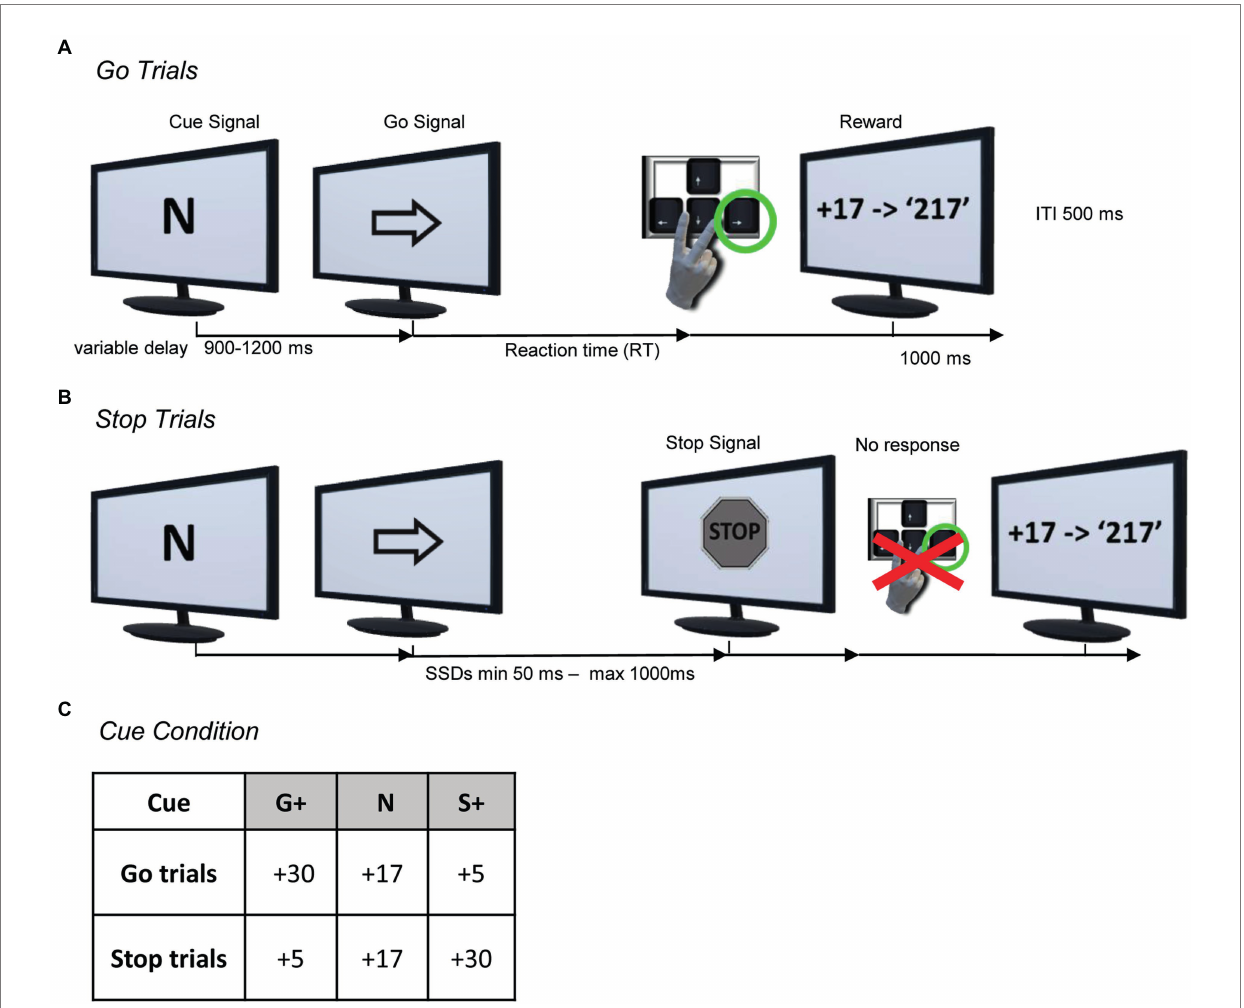
FIGURE 1 Behavioral paradigm. (A,B) Modified version of the Stop-Signal Task (sequence of events for the Neutral Condition; i.e. Cue: N). Each trial started with the Cue Signal, which indicated the type of reward condition to the subject; i.e., the amount of the reward they should expect if they correctly performed the Go Trial (see A ) or a Stop trial (see B ). After a variable delay, a Go Signal (right or left arrow) appeared and the subject had to press the arrow key on the keyboard according to the Go Signal to receive the reward as points (see A ) . Occasionally, at a variable delay (SSD) from the Go Signal, a Stop Signal appeared and the subject had to inhibit the action to receive the reward (see B ). (C) Overview of the Cue Signals associated with the respective rewards for each Cue Condition. The amount of reward for every Cue Condition was differently associated with Go and Stop Trials as follows: Go+ Condition (G+, as Cue Signal) was associated with higher reward for successful Go Trials compared to successful Stop Trials; Stop+ Condition (S+, as Cue Signal) was associated with reversed reward amount; Neutral Condition (N, as Cue Signal) was associated with equal amounts of reward for successful Go or Stop